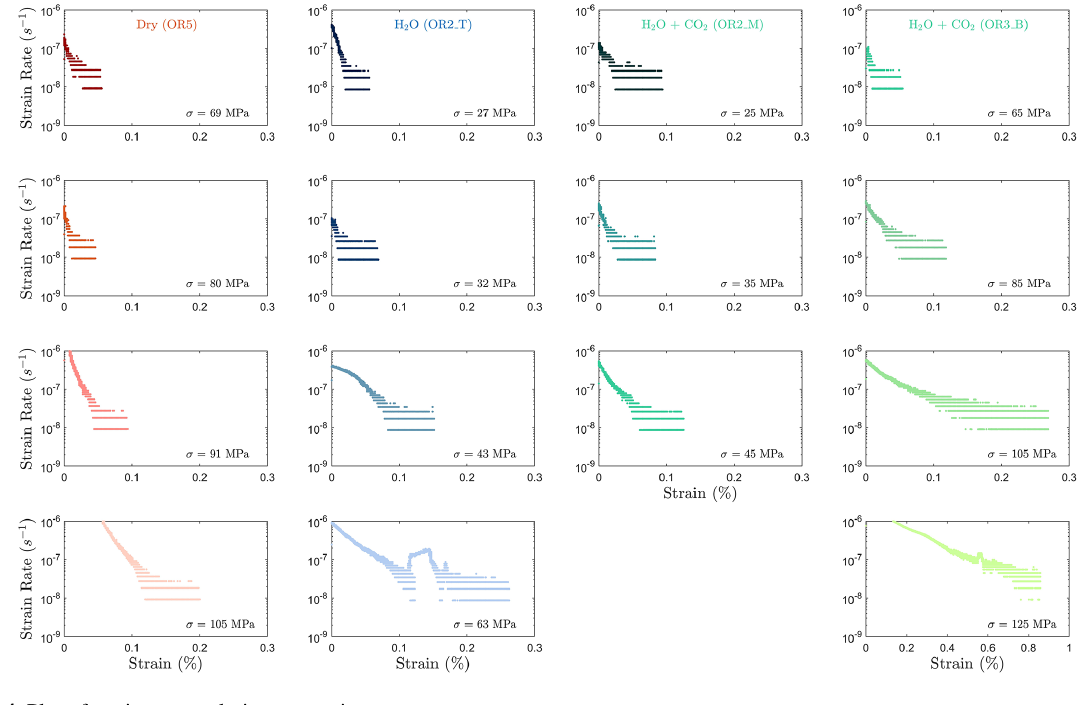
Figure A4. Plot of strain rate evolution vs. strain.